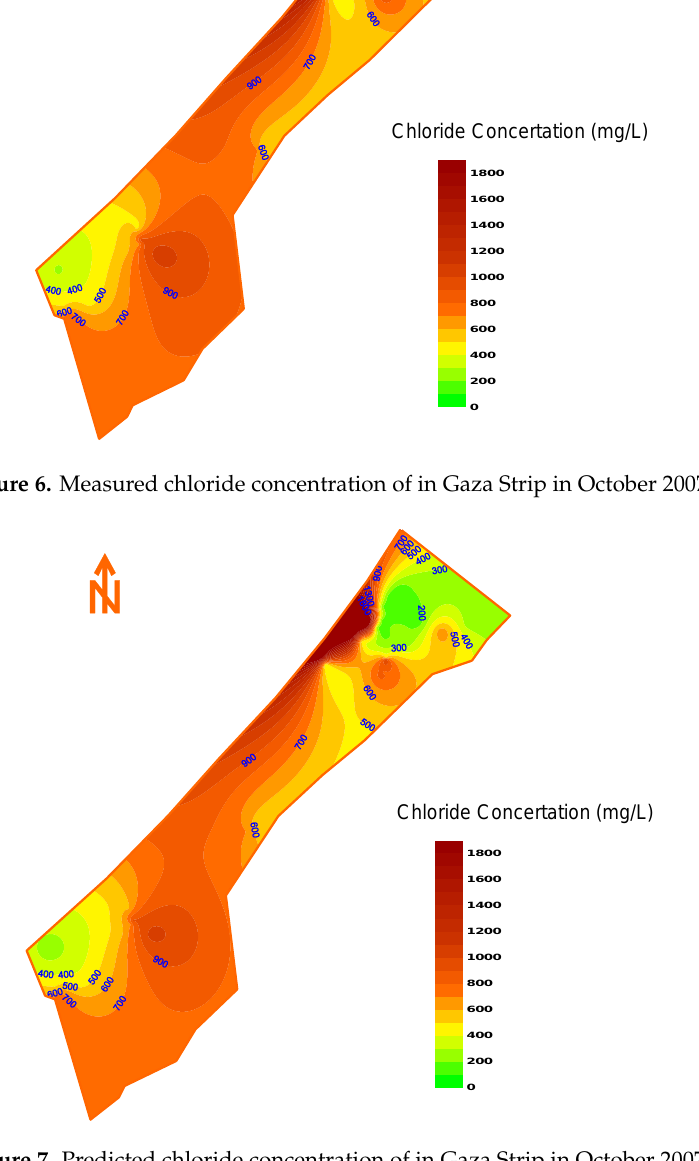
Figure 7. Predicted chloride concentration of in Gaza Strip in October 2007.